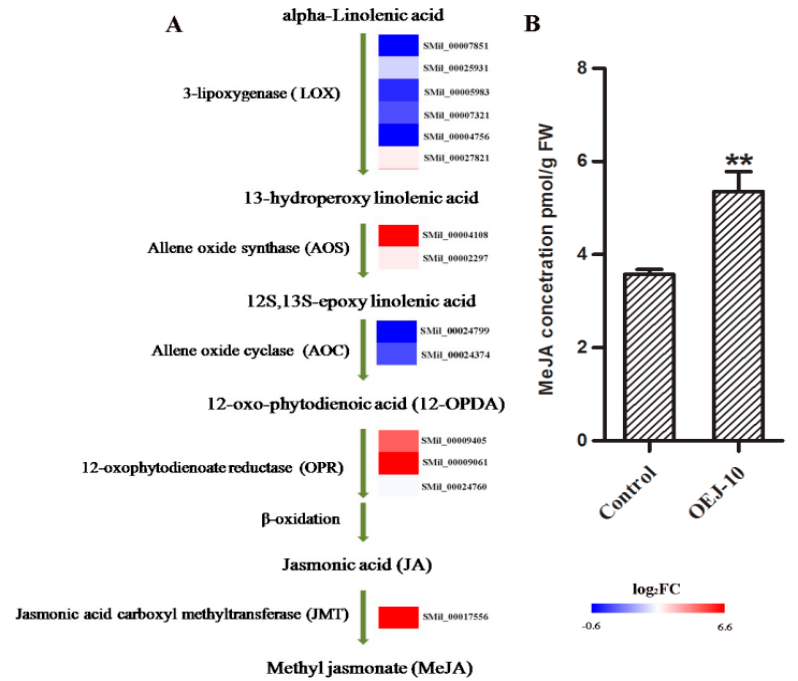
Figure 7. ( A ) DEGs involved in the pathway for MeJA biosynthesis between OEJ-10 and the control. For each gene, relative expression (OEJ-10 versus control) is represented as log 2 FC. The color scale is shown at the bottom. Higher expression levels are shown in red. ( B ) Concentrations of MeJA in leaf extracts from transgenic line OEJ-10 and the control. All data are means of three replicates, with error bars indicating SD. ** Values are significantly different from the control at p < 0.01.